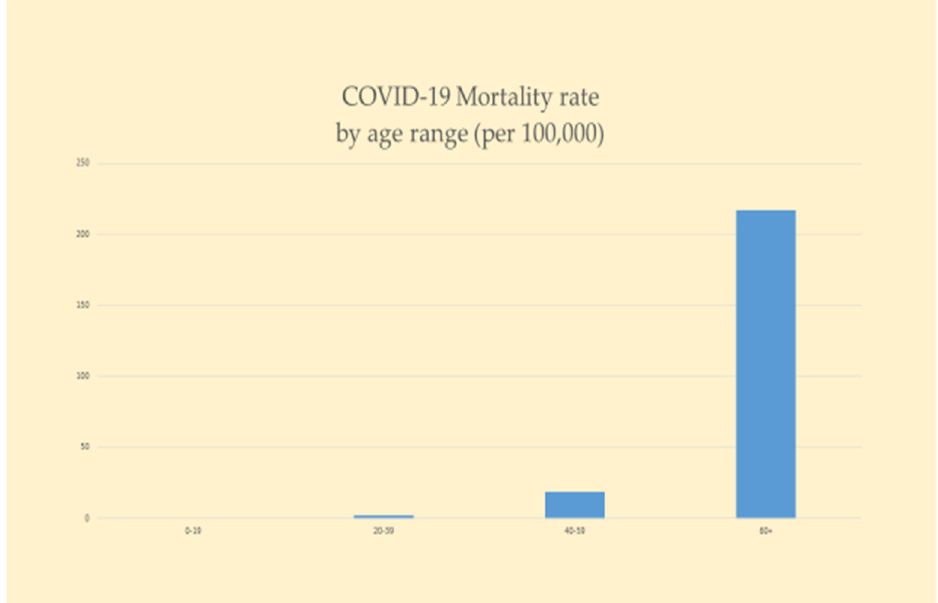
Figure 12. Crude mortality rates of COVID-19 by age in Wuhan.